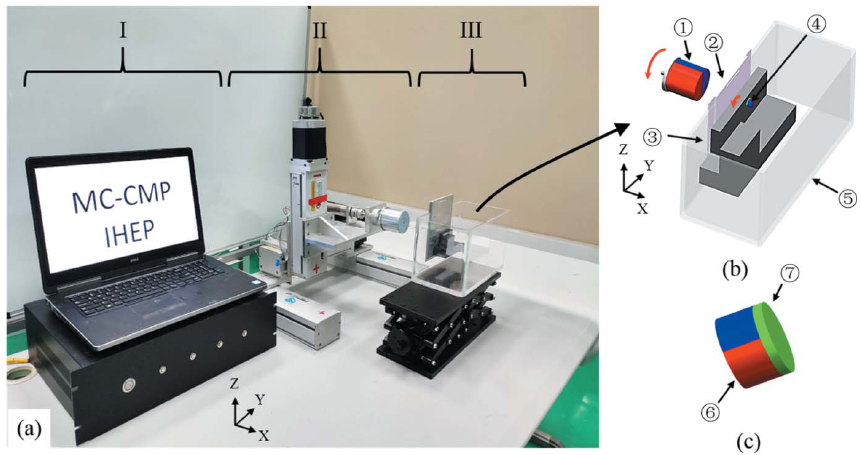
Figure 1 ( a ) Photograph of the MC-CMP system, showing (I) the computer and driver, (II) the gantry guide rail and rotating mechanism of the driving magnet, and (III) the vessel system. ( b ) Details of the vessel system. ( c ) Small polishing magnet. Major components are numbered: (1) large magnet and its motion mechanics including rotation and X/Y/Z rectilinear motion; (2) pad which can be inserted into the vessel; (3) channel-cut crystal that can be mounted on the pad (2); (4) small polishing tool; (5) vessel filled with slurry or polishing solution; (6) mini magnet; (7) covering layer; additional material can be added on the mini magnet when different processes are carried crystals are given in Fig. S5 and Table S3 of the supporting information.